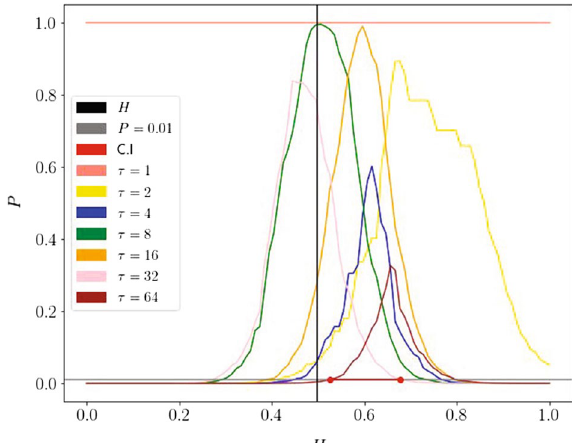
Fig. 5 Confidence interval of H s for which the series is self‑similar at 94.15%